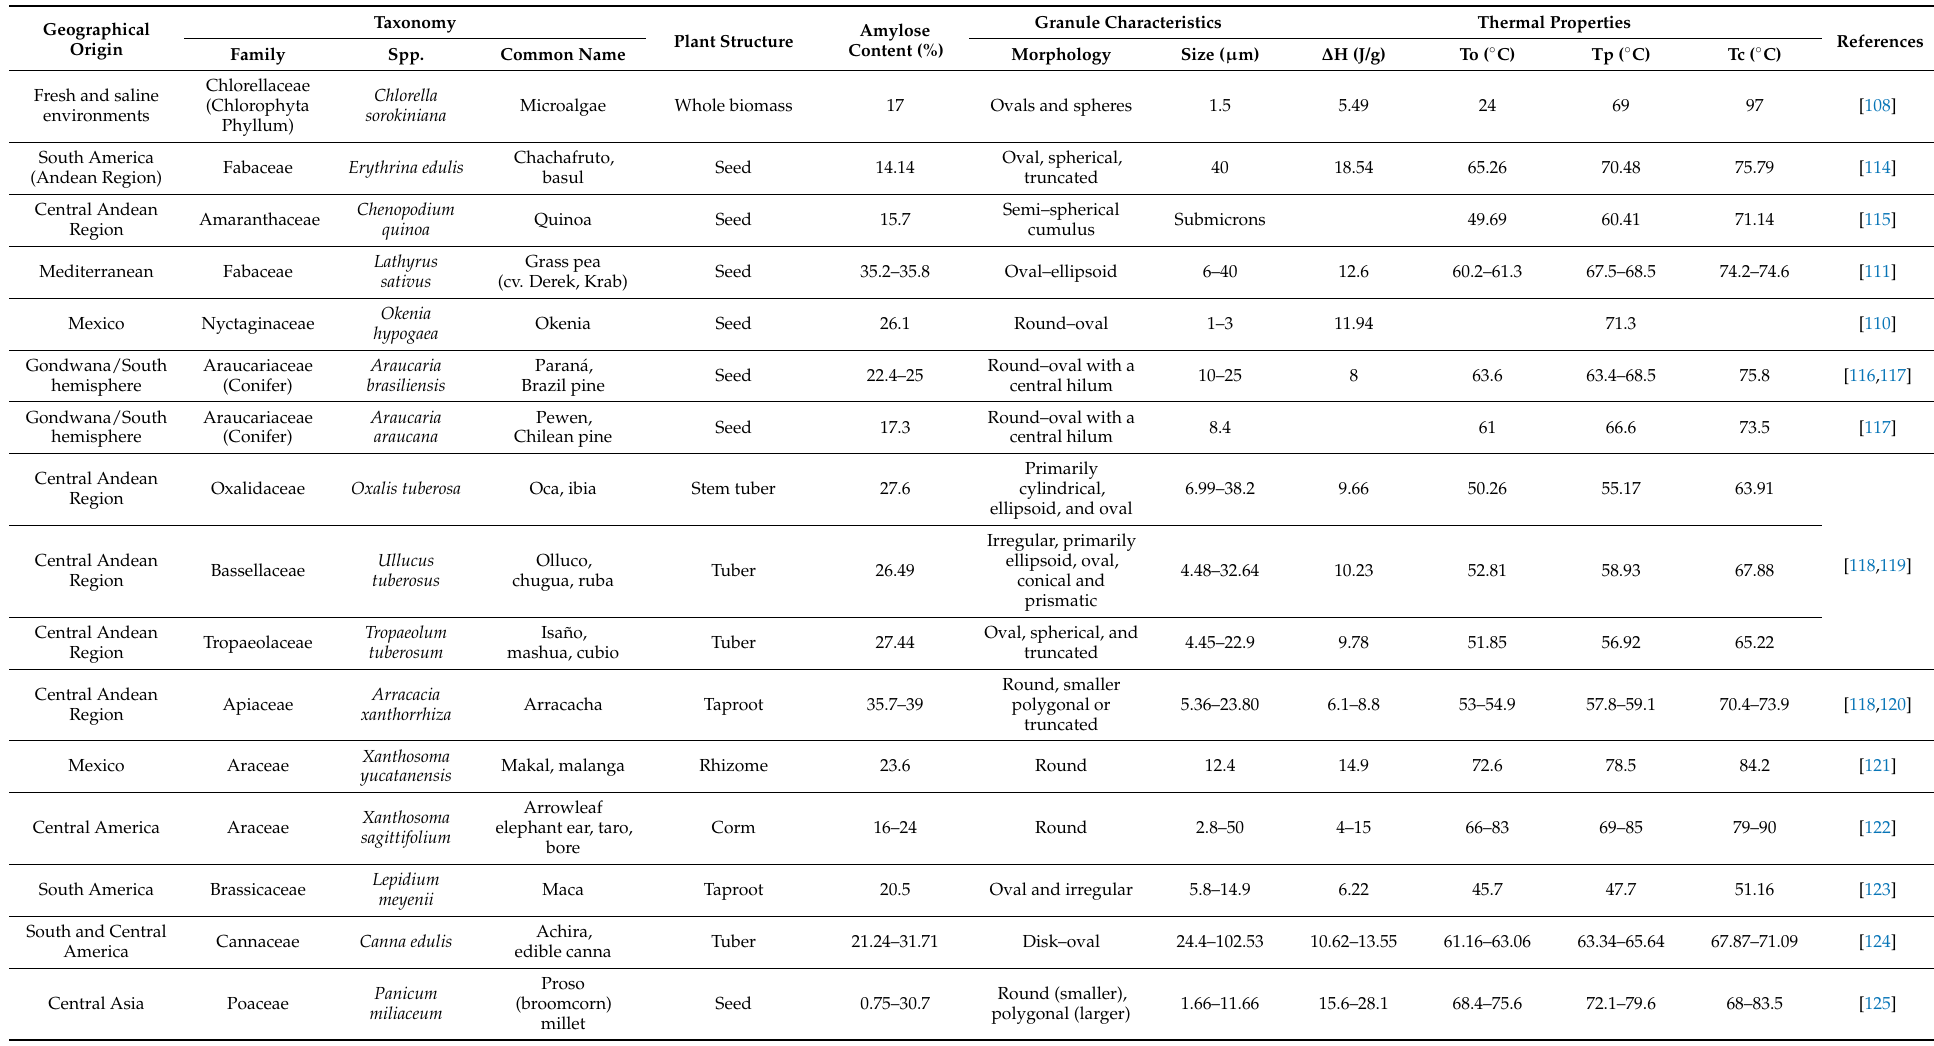
Table 2. Nonconventional starch sources, botanical origin, and thermal